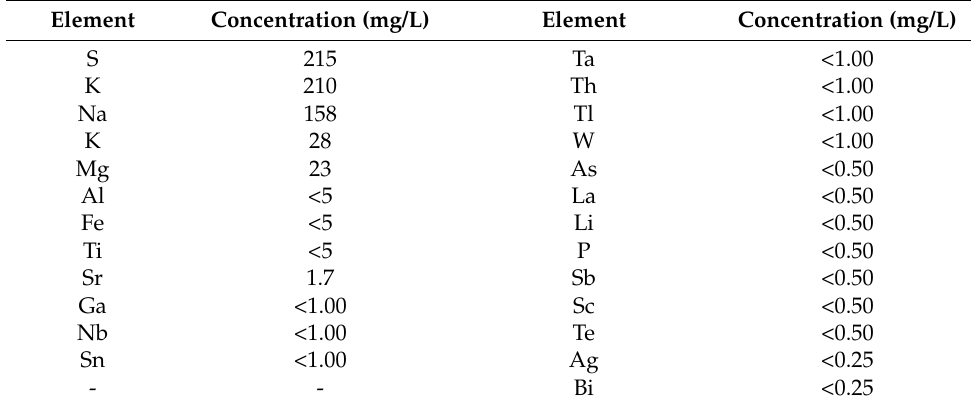
Table 2. Chemical characterization test results of industrial water using ICP.